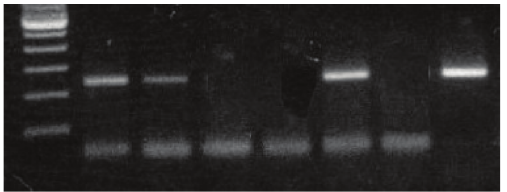
Figure 1: Agarose gel analysis of endometrial adenocarcinomas by PCR using HPV 16 type-specific primers. Line 1 (marker 100bps), lines 2, 3, 6 (positive samples), lines 4, 5 (negative samples), line 7 (negative control), and line 8 (positive control).